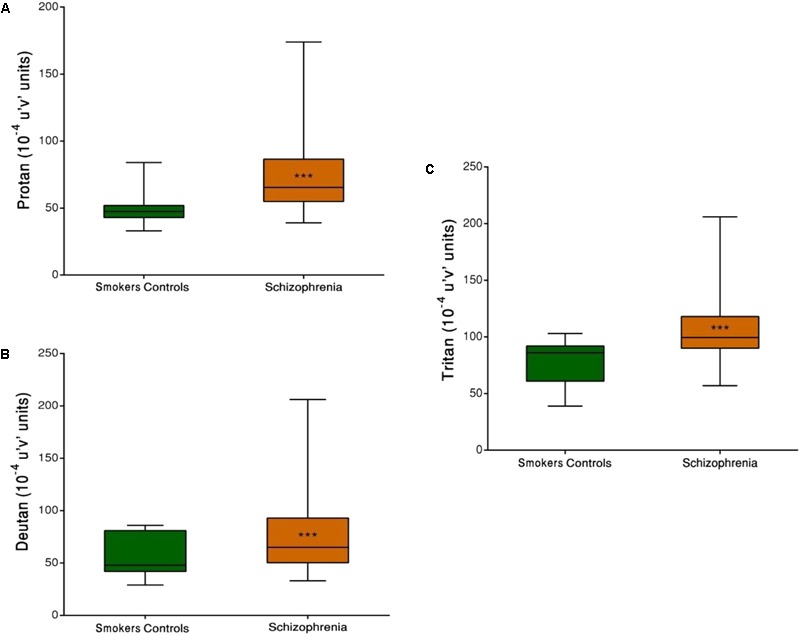
Trivector test, showing boxplots for protan (A), deutan (B), and tritan (C) confusion lines. The data are presented in 10-4 u’v’ units. Each boxplot is based on the results of 40 participants. ∗∗∗p < 0.001.